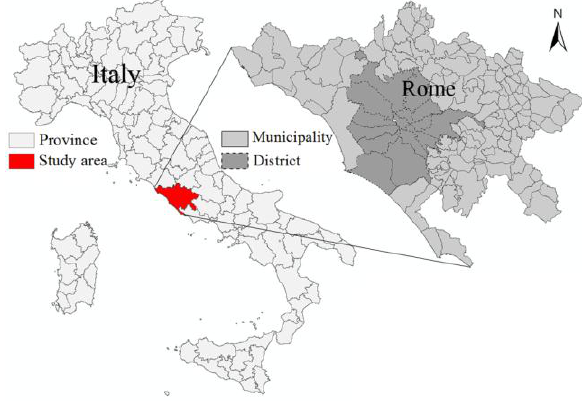
Figure 1. Geographic location of the Urban Atlas dataset used: Province of Rome, region of Lazio, Italy Additionally, the municipality boundaries inside the province of Rome were obtained from the Global Administrative Areas database (GADM, 2011), and the district boundaries inside the municipality of Rome from Iptsat (2013). Both datasets were available in vector format, and after a revision and edition process to match their boundaries were finally merged into a single